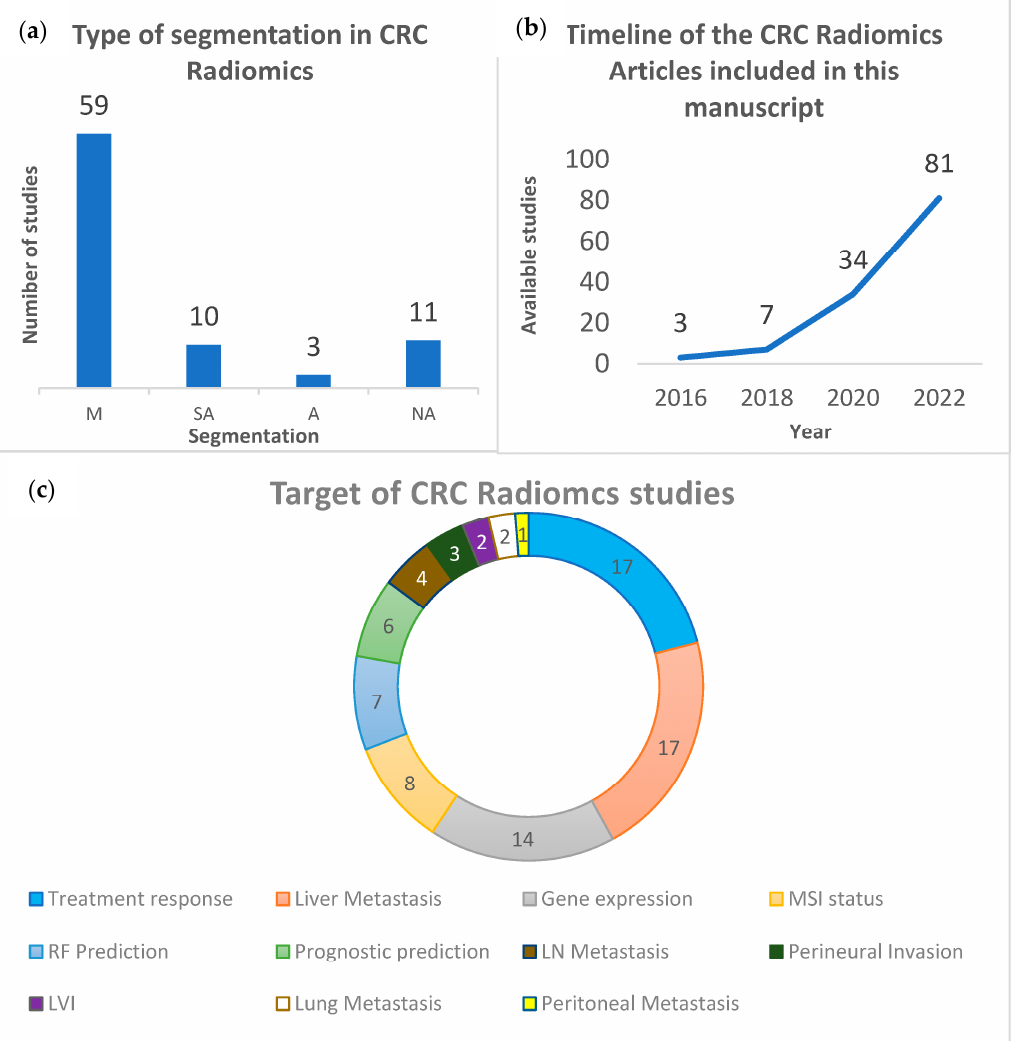
Figure 5. ( a ) Number of CRC-Radiomics articles that used manual (M), semi-automatic (SA) and automatic (A) segmentation. (NA: Not Available). ( b ) Timeline of the CRC-Radiomics articles published since 2016 included in this manuscript. ( c ) Number of CRC-Radiomics articles according to their target.